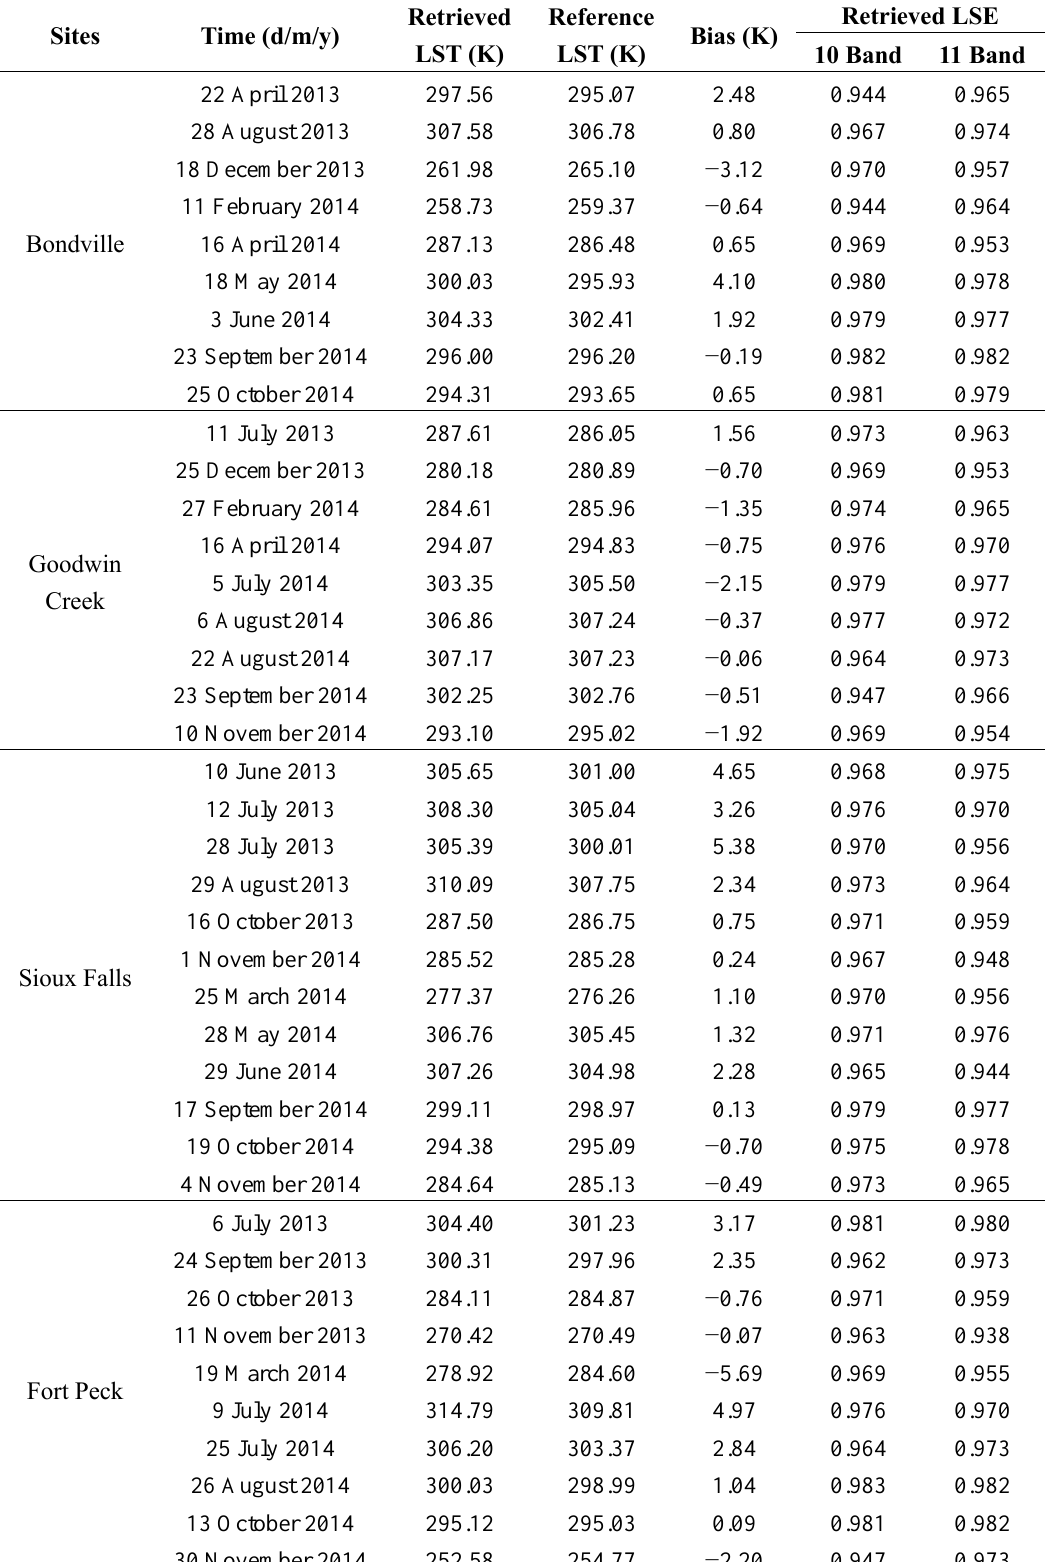
Table 6. Validation cases based on the SURFRAD ground measurements. Retrieved LST/LSE means the LST/LSE is retrieved from satellite images by the algorithm in this study, the reference LST means the LST is calculated from SURFRAD ground measurements. Bias is the retrieved LST minus the reference LST.